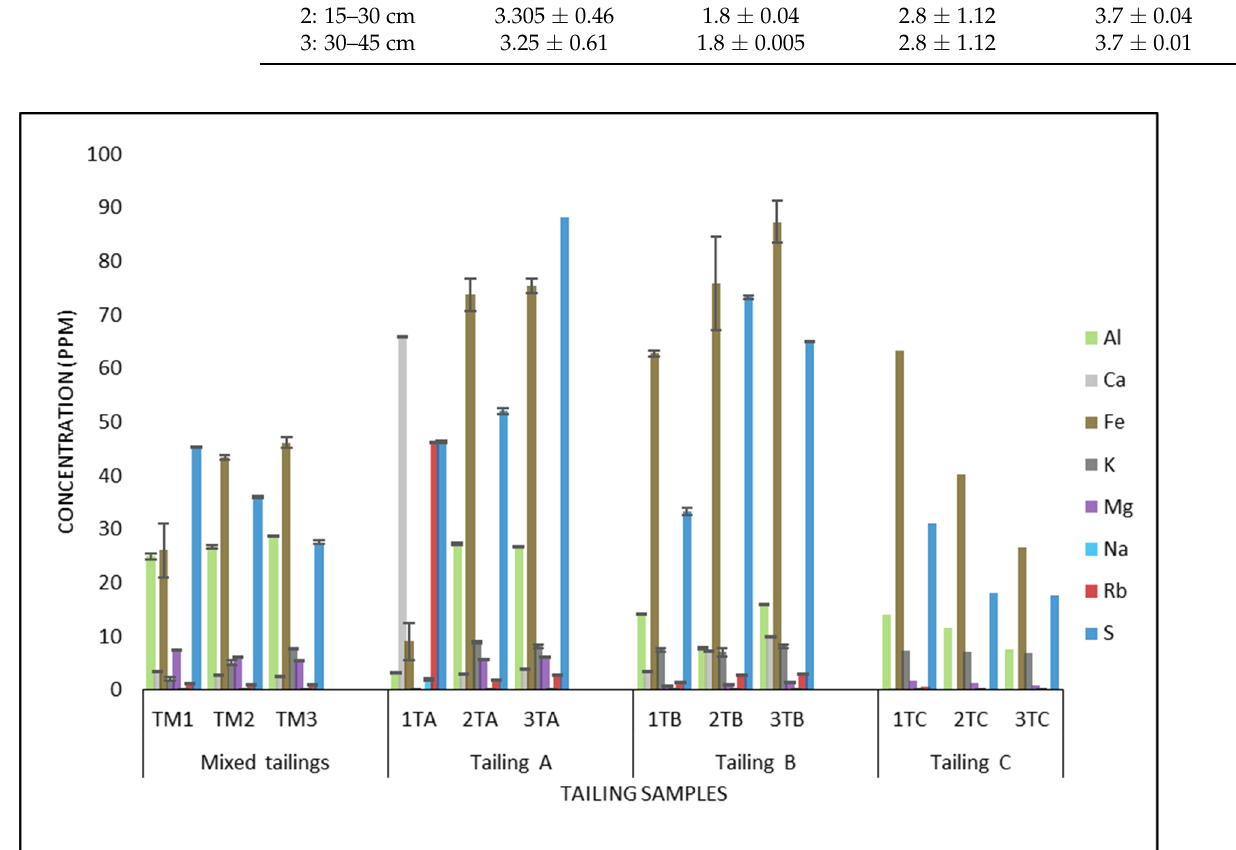
Figure 1. Heavy metal characterization of 4 different tailings at different depths. 1–3—sampling depth, T—tailing, A–C—different tailings, and M—mixed tailing .